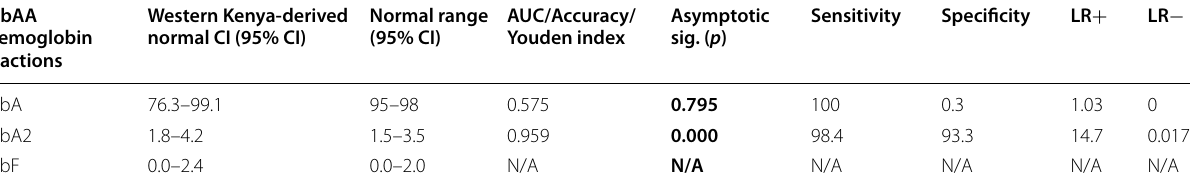
Table 2 HbAA hemoglobin fractions HbAA